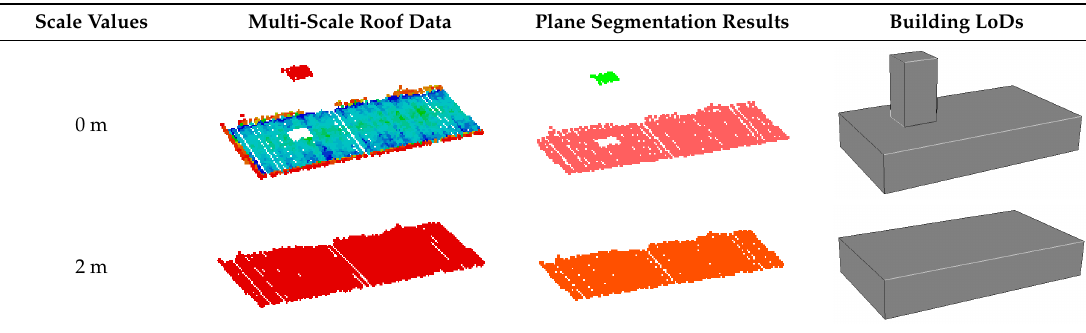
Table 2. First example of generating the LoDs for the building of Figure 6.